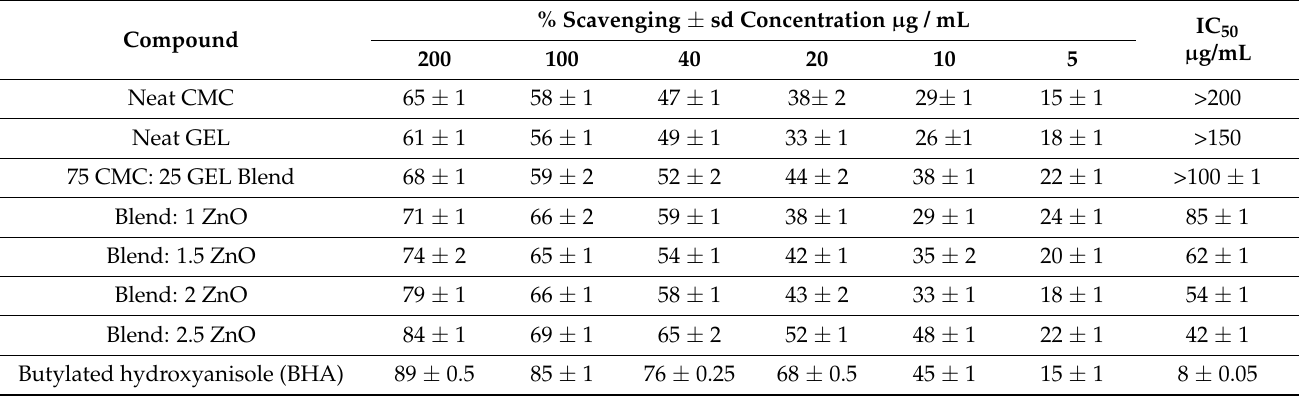
Table 5. Antioxidant results of CMC/GEL films loaded with different concentration of ZnO-Nps.